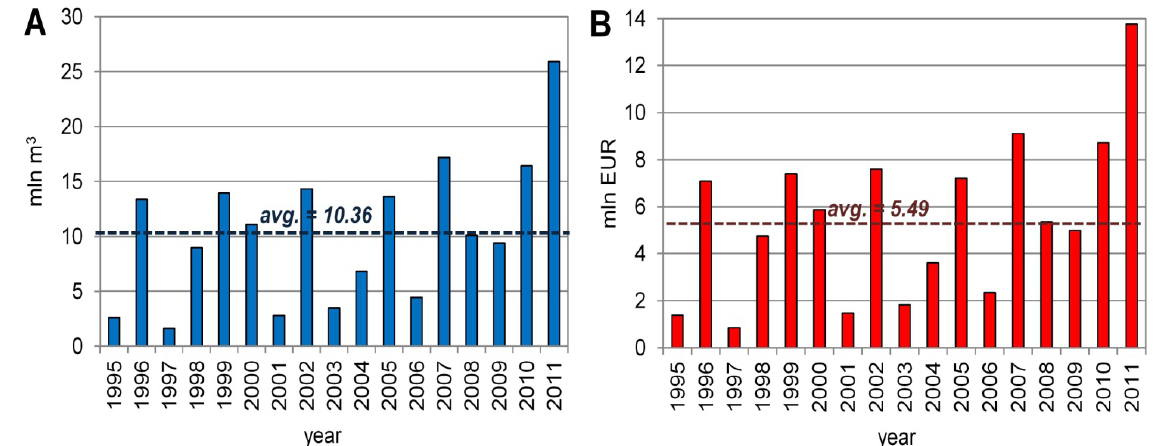
Figure 7. ( A ) Volume of water stored within the floodplain of the Lower Biebrza Basin in particular years of the period 1995–2011; and ( B ) The annual monetary value of water stored within the floodplain of the Lower Biebrza Basin, in particular years of the period 1995–2011.